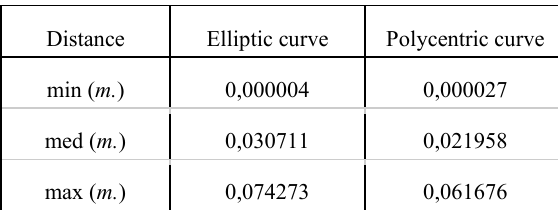
Table 1 . Distance between point cloud section and geometric curve.